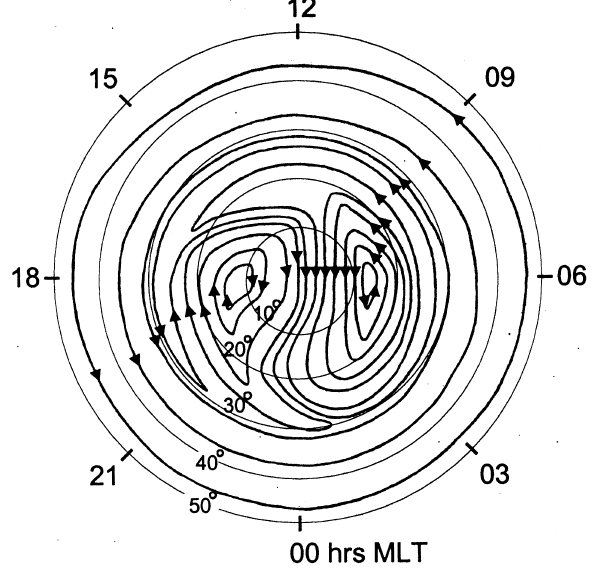
Fig. 8. Simulated distribution of the electron concentration ( × 10 12 m − 3 ) at h = 300 km. The projection of the vertical plane shown in Fig. 6 at MLT = 21:00 is presented by the bold